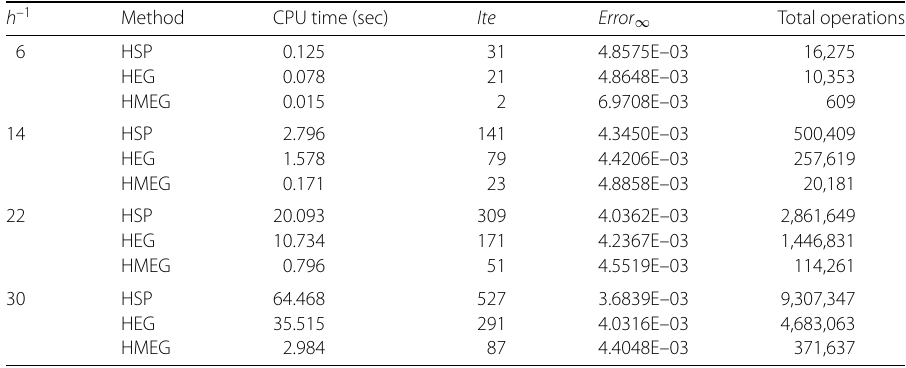
Table 3 The numerical results of the HSP, HEG and HMEG methods at α = 0.3 for Example